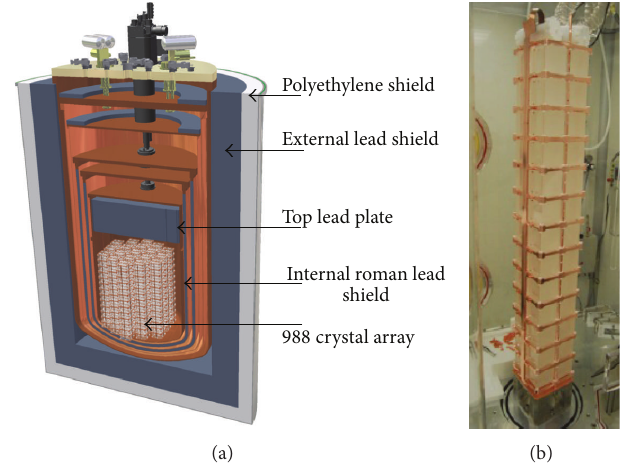
Figure 10: (a) The CUORE setup. (b) CUORE-0